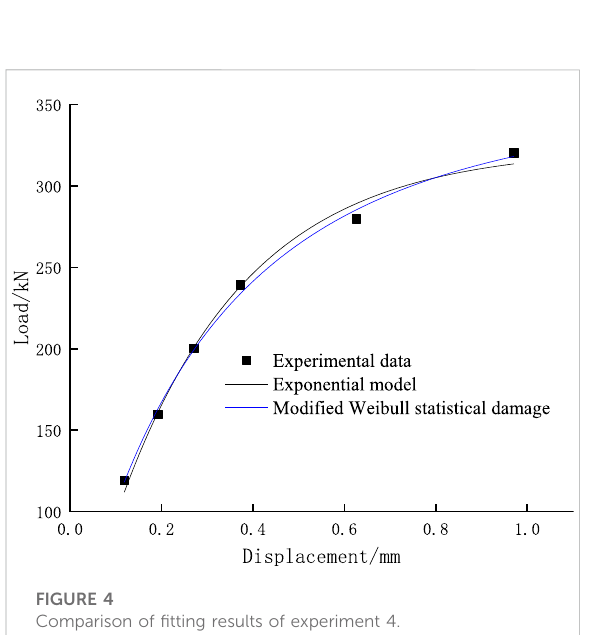
FIGURE 3 Comparison of fi tting results of experiment 3.